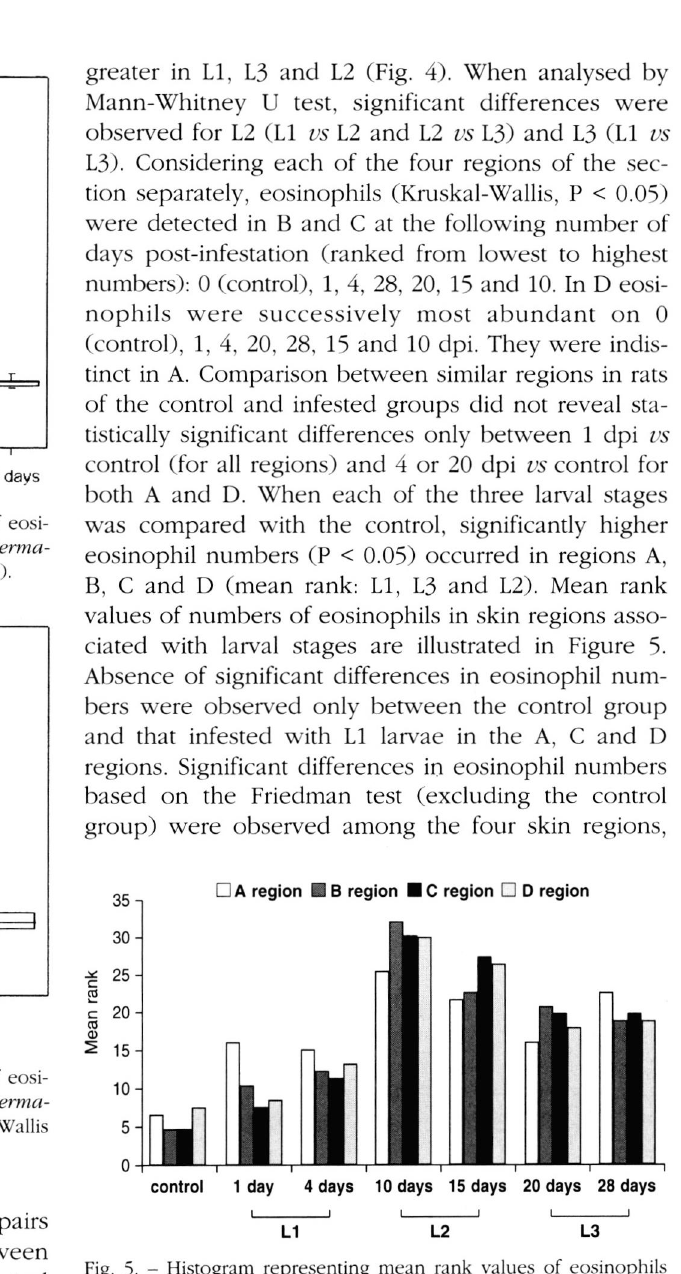
Fig. 5. - Histogram representing mean rank values of eosinophils in the skin of control rats and those infested with Dermatobia bominis larvae, indicating the different regions or sections and three larval stages (LI, L2,